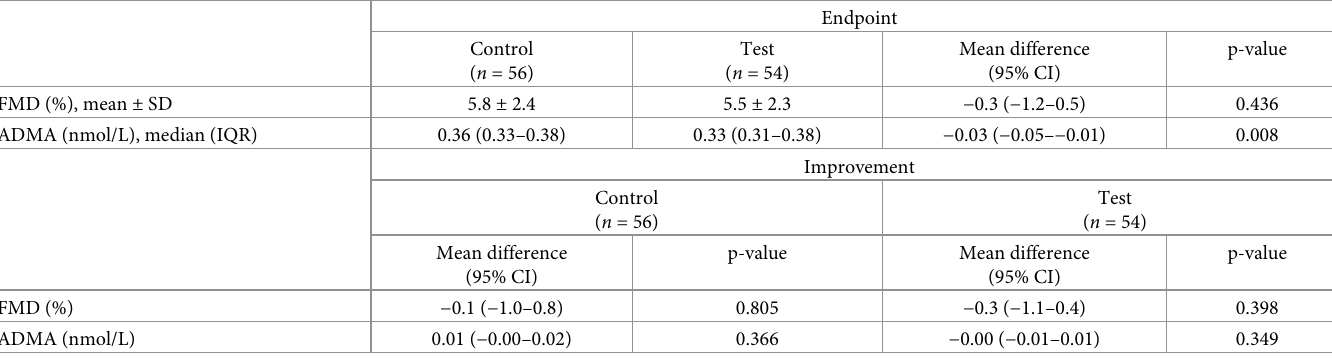
Table 2. Assessment of vascular function at 3 months after the start of the